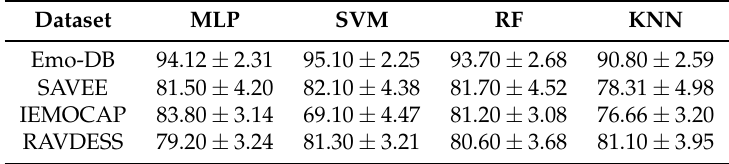
Table 2. Weighted average recall and standard deviation of speaker-dependent SER experiments with feature selection.